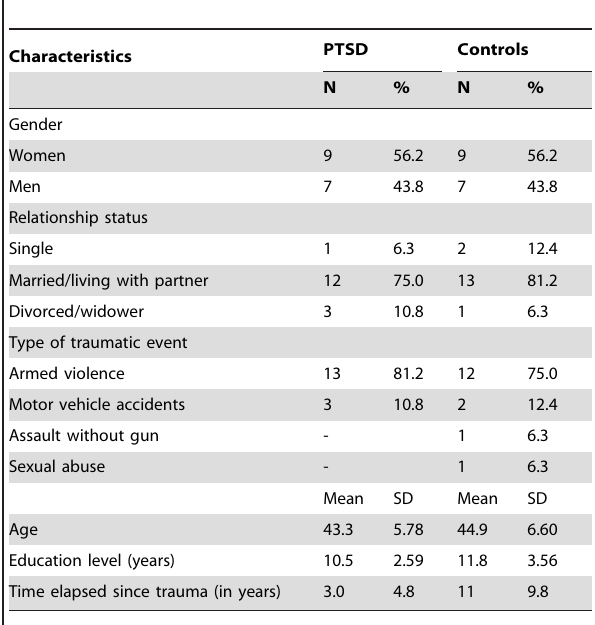
Table 1. Characteristics of the sample